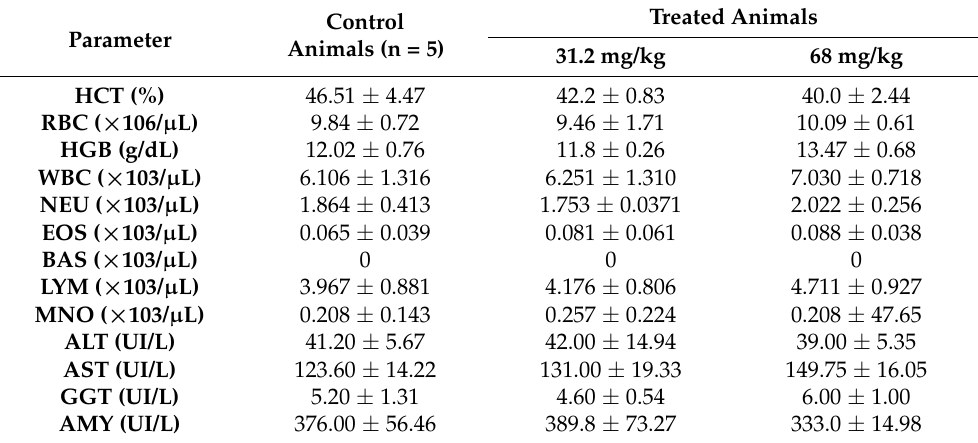
Table 1. Hematology and serum chemistry parameters of mice treated with 1A-116 and controls. Parameter